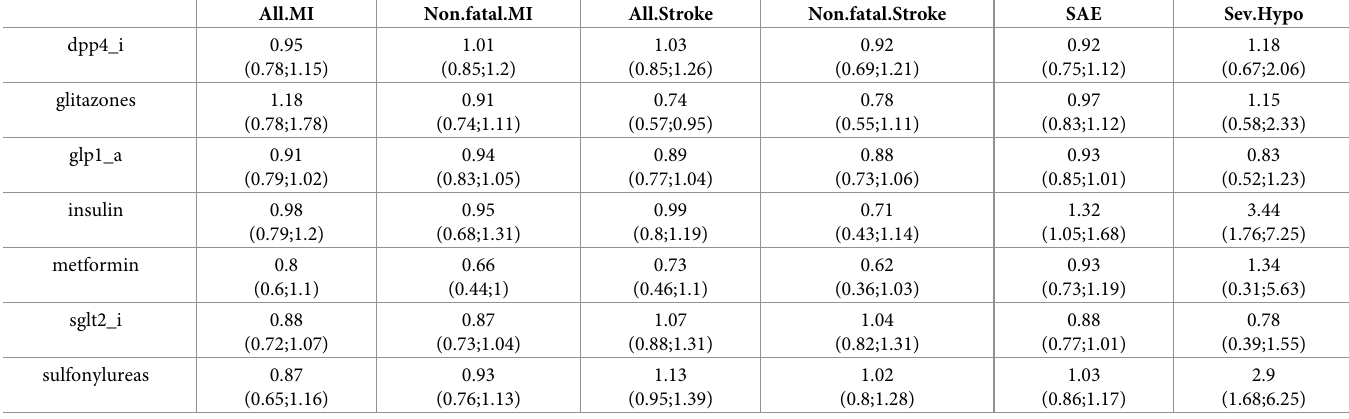
Table 5. Summary of treatment effect compared to control for secondary outcomes.